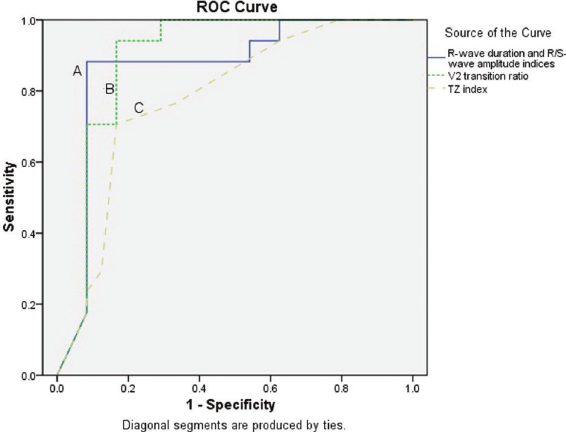
Figure 3. AUCs of the three algorithms in patients with rotation. AUC A : V 2 R wave duration and R/S wave amplitude indices = 0.86; B : V 2 transitional ratio = 0.89; C : TZ index = 0.78